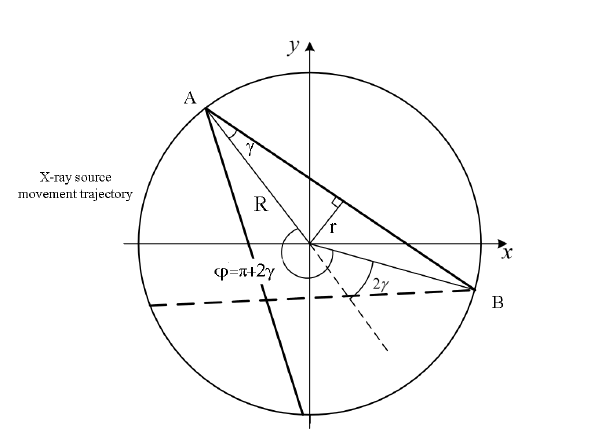
Figure 2. Derivation of the minimum scanning angle of the sector